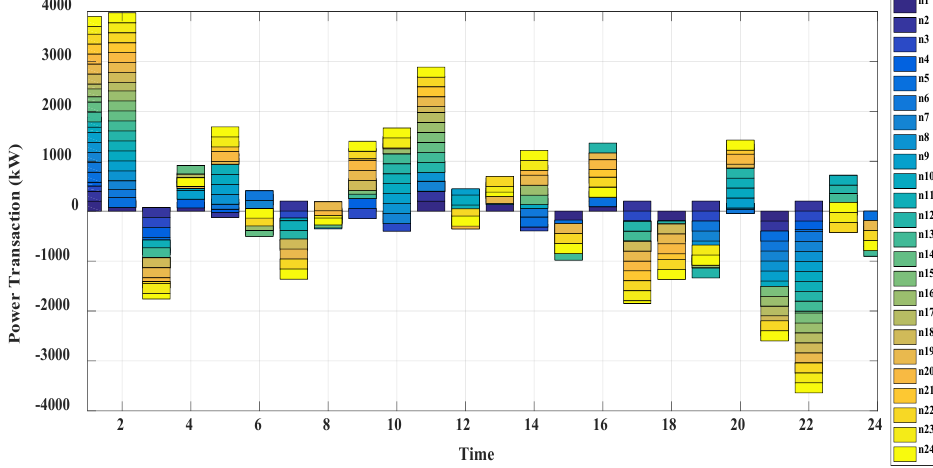
Figure 7. The power transaction between the grid and the hub system.